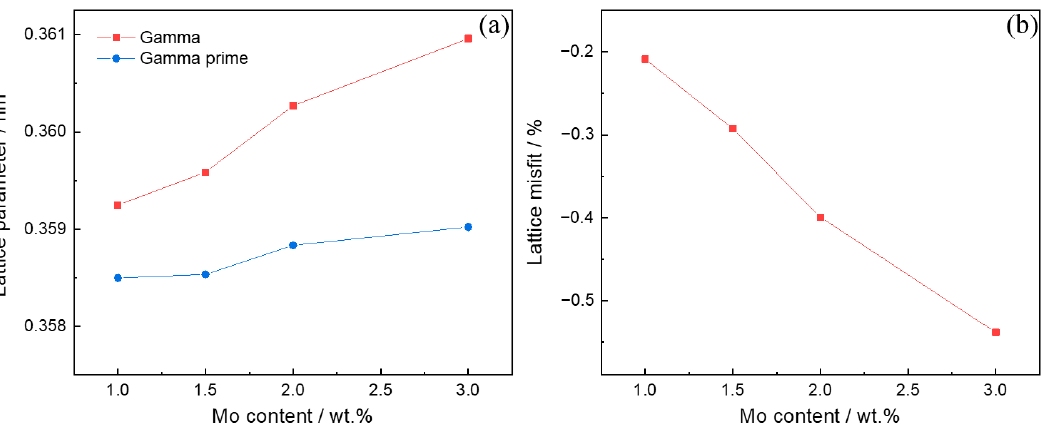
Figure 6. ( a ) Lattice parameters of the γ and γ′ phases and ( b ) lattice misfit of the alloys with differ- ent Mo contents.